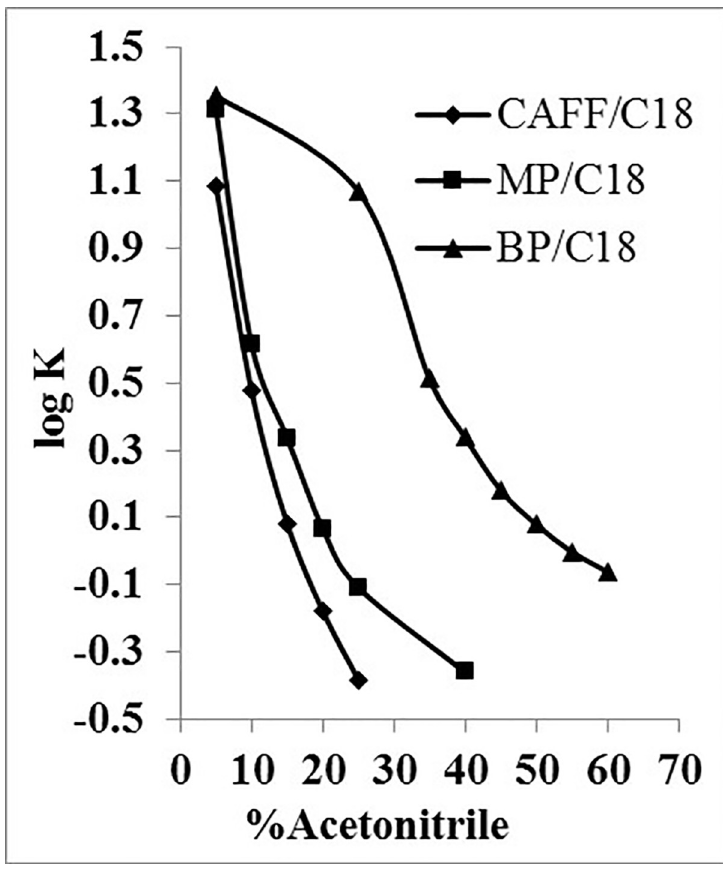
Fig 2. log K of CAFF, MP and BP as a function of acetonitrile concentration using C18 column.